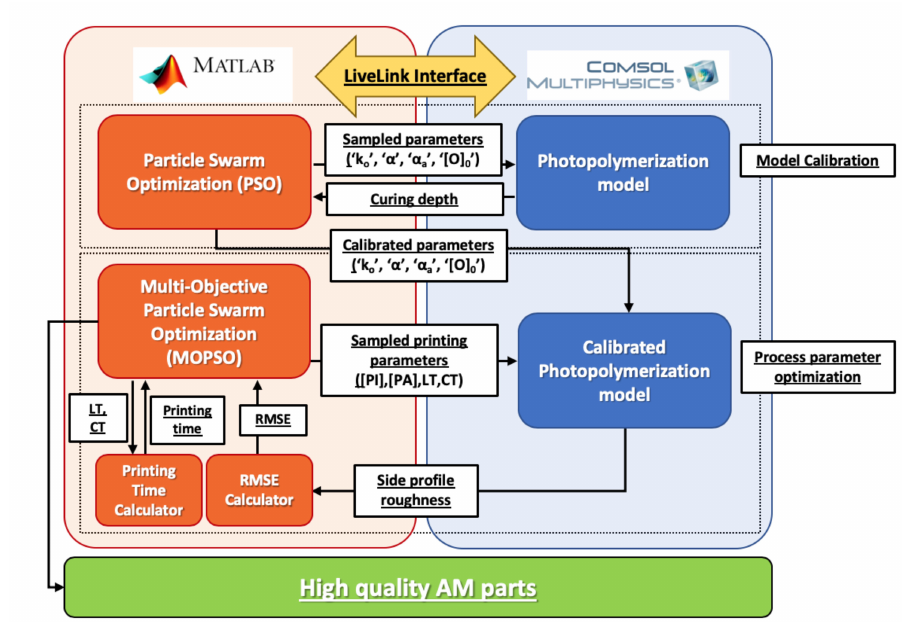
Figure 5. Flow chart of MATLAB LiveLink interface with COMSOL Multiphysics. Proposed modeling framework consists of two sub-steps: model calibration and process parameter optimization. The flow of data is shown as arrows and